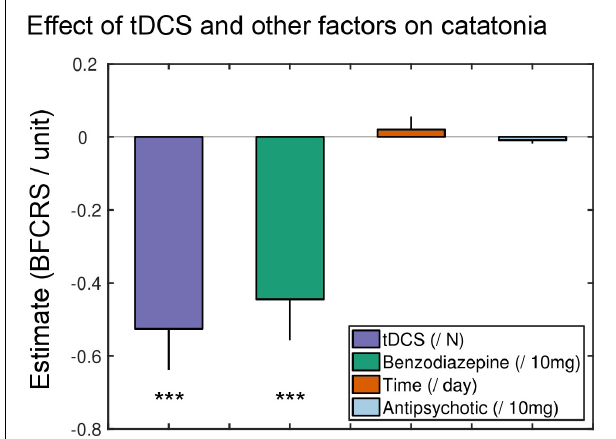
FIGURE 3 | Effect of tDCS and other factors on BFCRS. Coefficient estimates of the general linear mixed model. TDCS regressor was expressed in number of sessions since the beginning of the course, meaning that each tDCS session resulted in a 0.45 decrease of BFCRS score. Time was expressed in days. For benzodiazepine and antipsychotic a proxy for concentration was computed (see section “Materials and Methods”). For comparability of estimate size, benzodiazepine regressor was expressed in centigram (10 mg) of diazepam equivalent while antipsychotic regressor was expressed centigram of chlorpromazine equivalent. Error bars represent standard errors of coefficient estimates. ***Statistically